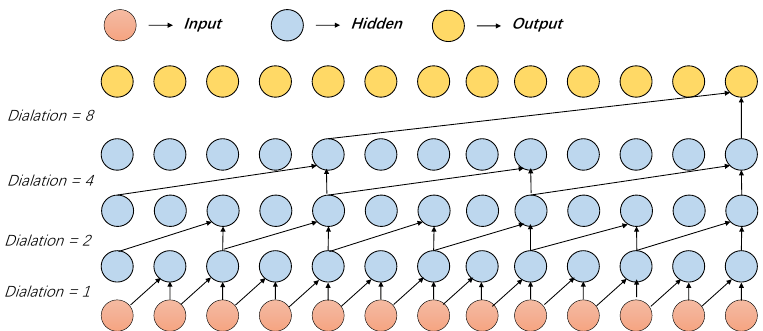
Figure 4. Casual Dilated Convolutional